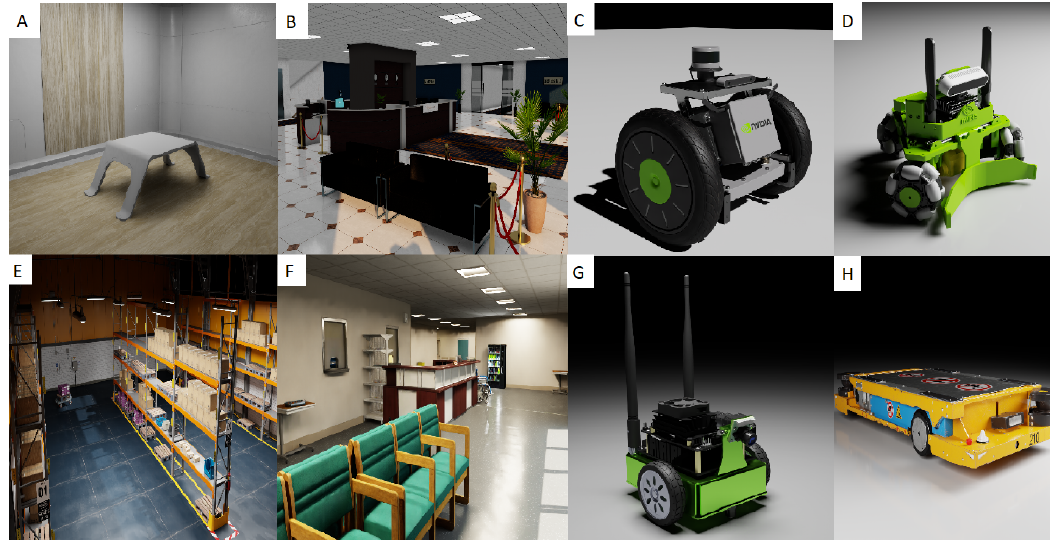
Figure 5. Some of the Isaac Sim’s included assets. ( A ) Tiny room, ( B ) Office floor, ( C ) Carter V1 robot, ( D ) Kaya robot, ( E ) Warehouse, ( F ) Hospital floor, ( G ) Jetbot robot, ( H ) Smart Transport Robot.